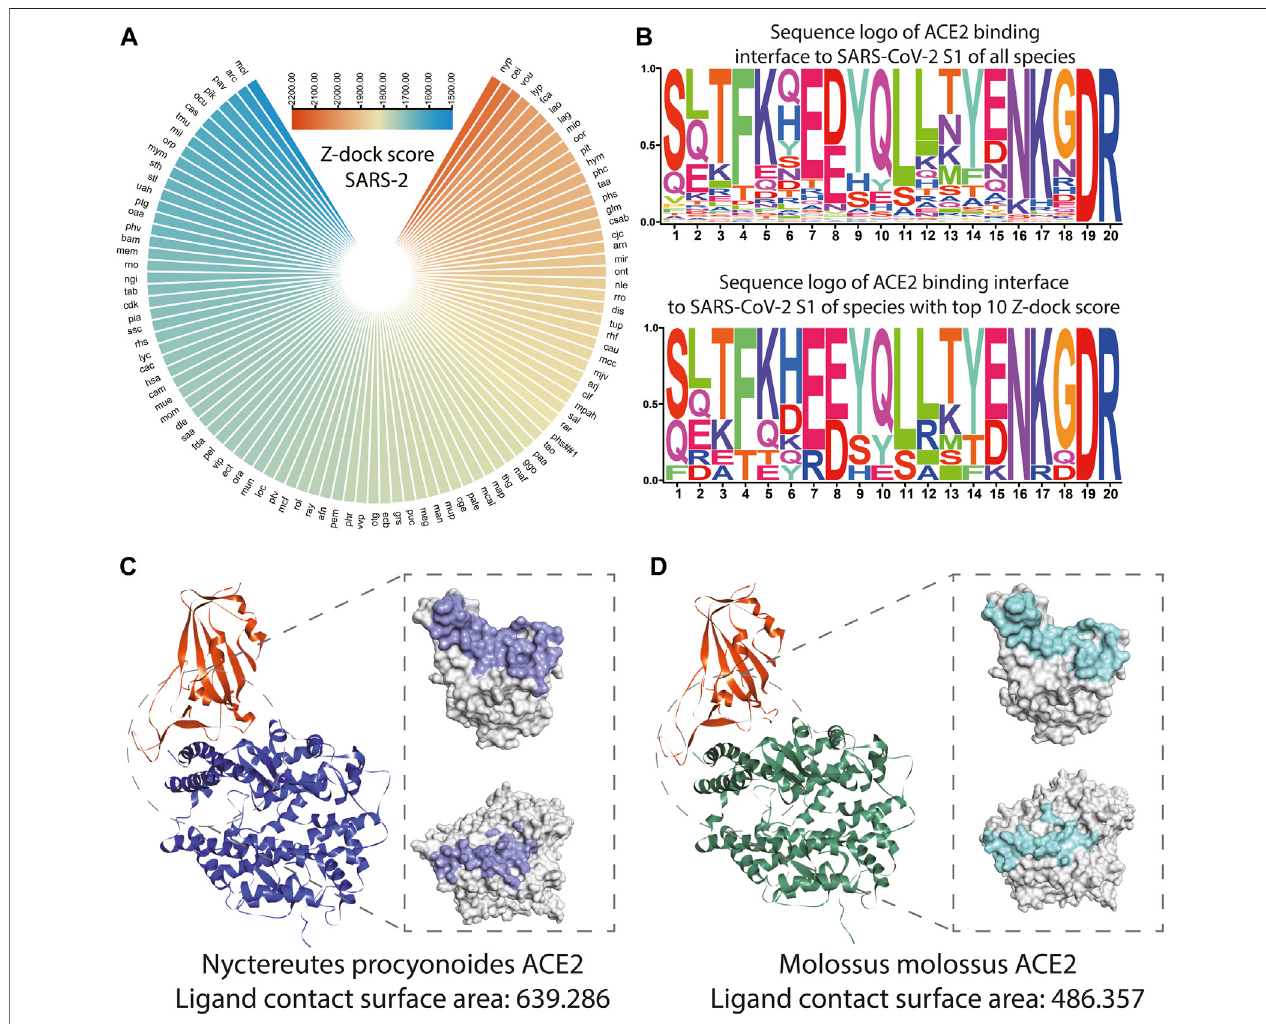
FIGURE 4 | Structure and binding af fi nity analysis of SARS-CoV-2 S1 proteins with ACE2s among species. (A) Polarized heatmap showing the Z-dock score of SARS-CoV-2 S1 protein and host ACE2 among species. (B) Sequence logo of ACE2 binding interface to SARS-CoV-2 S1 of all species and sequence logo of ACE2 binding interface to SARS-CoV S1 of species with the top 10 Z-dock score. (C) Overall and contact surface structure of SARS-CoV-2 S1-RBD in silico docked with simulated ACE2 structure of Nyctereutes procyonoides . (D) Overall and contact surface structure of SARS-CoV-2 S1-RBD in silico docked with the simulated ACE2 structure of Molossus